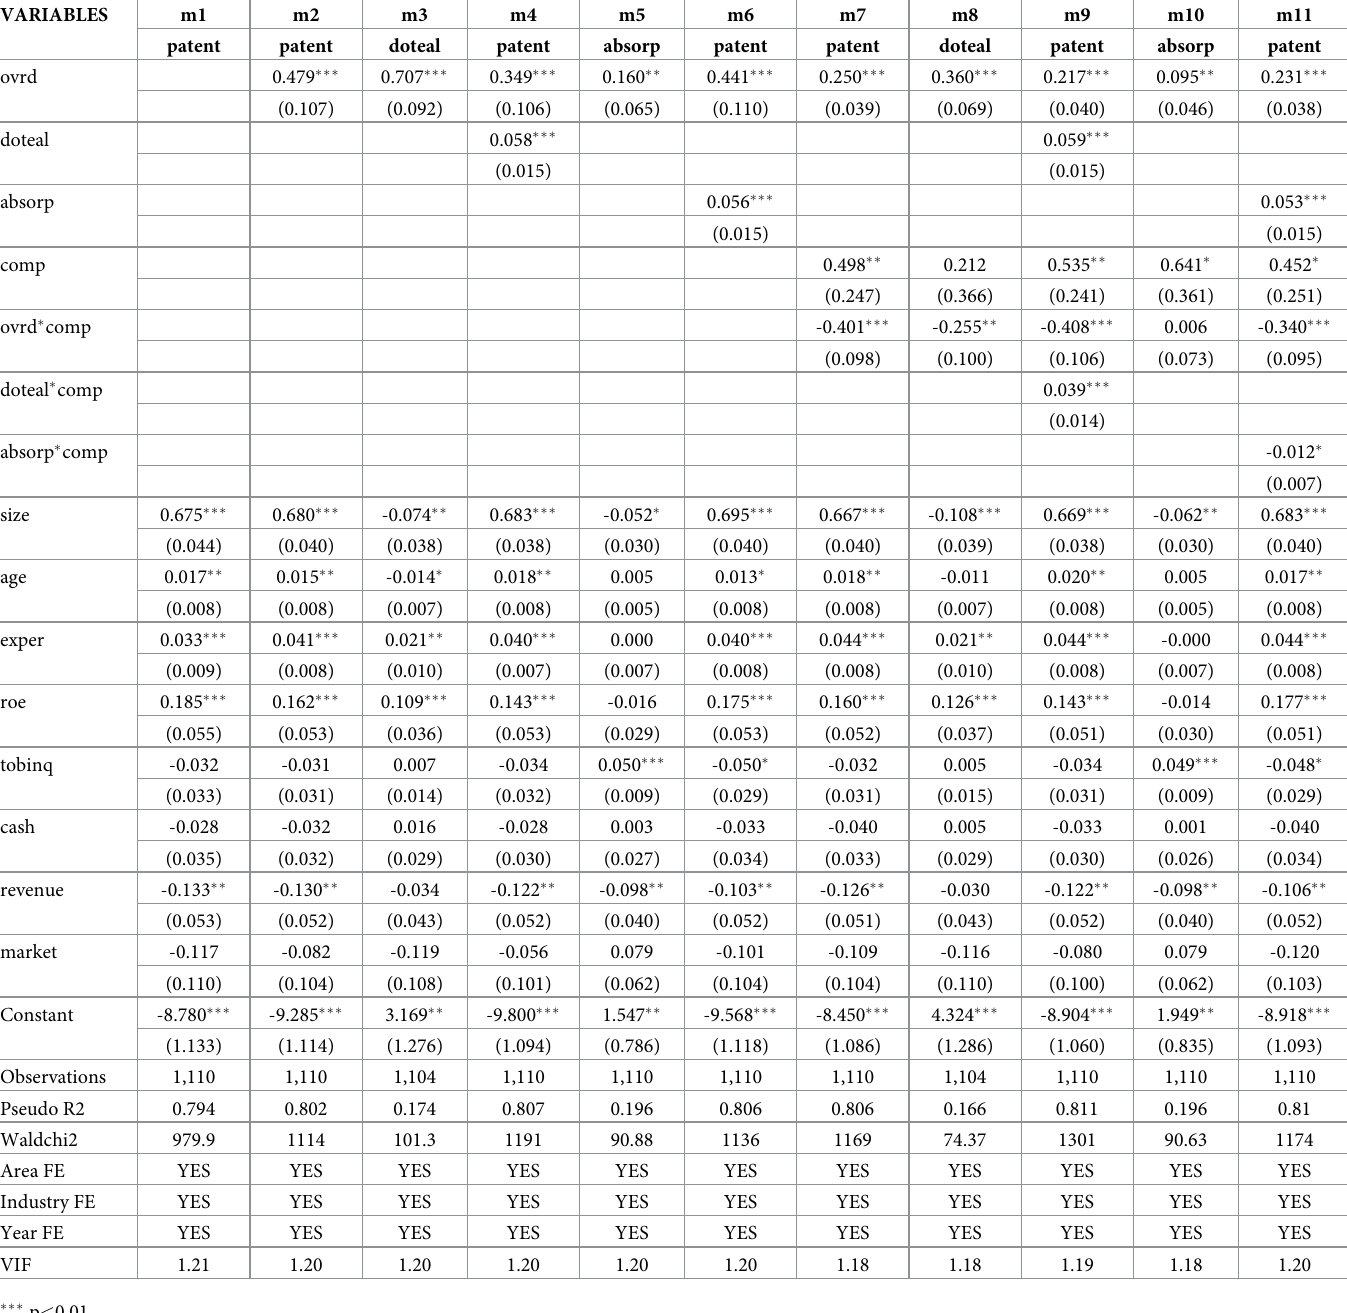
Table 3. Mediating effect test and moderated mediating effect